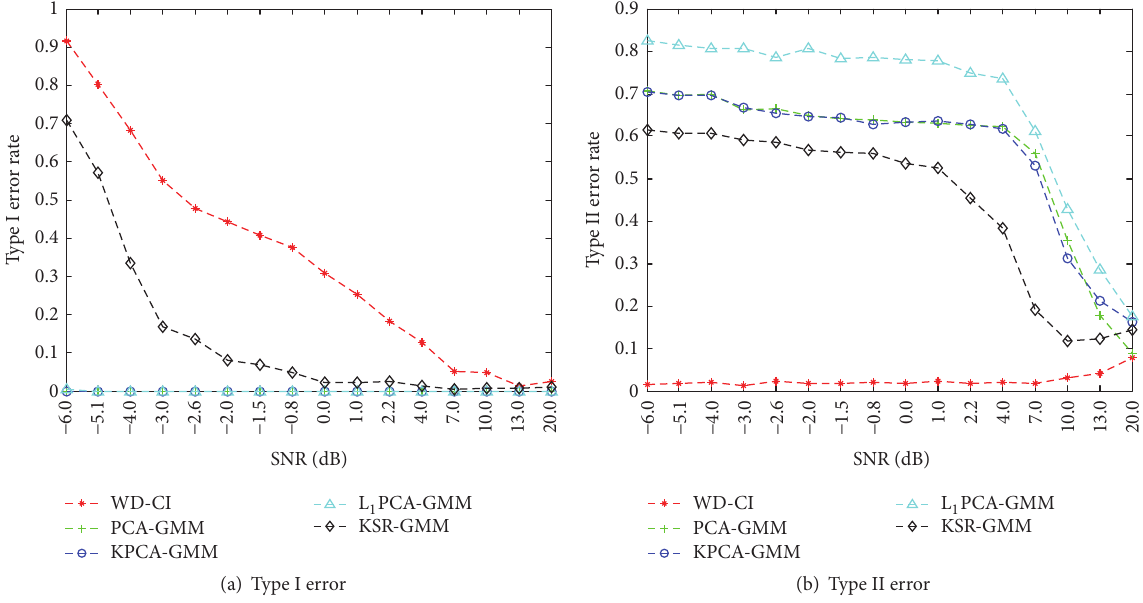
Figure 5: Statistical results achieved by different methods at different SNRs. SNRs were systematically varied by changing the variance of the red noise superimposed on the